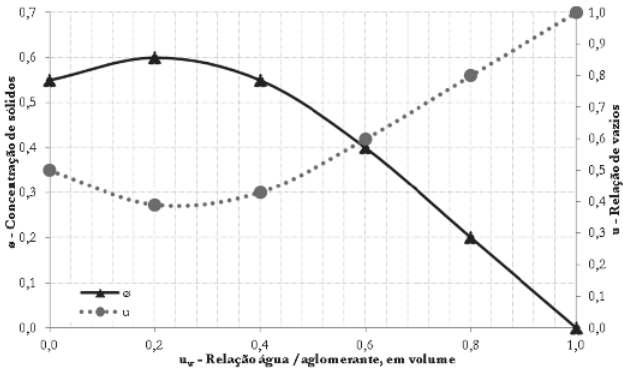
Figura 1 Gráfico típico obtido no ensaio de determinação da densidade de empacotamento na condição úmida, adaptado de [14; 37]